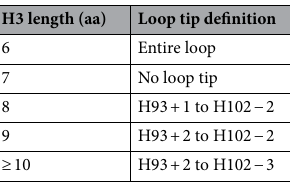
Table 5. Loop tip definition used for conformational ensemble generation with